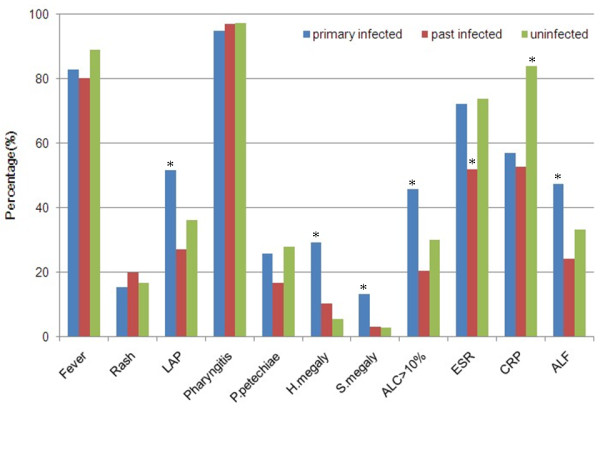
Main clinical features in patients grouped by detection of anti-EBV or anti-CMV antibodies. *Differs from the other two groups, p < 0.05. LAP: lymphadenopathy; P. petechiae: palatal petechiae; H.megaly: hepatomegaly; S.megaly: splenomegaly; ALC: atypical lymphocytes; ESR: erythrocyte sedimentation rate; CRP: C-reactive protein; ALF: abnormal liver function (alanine aminotransferase or aspartate aminotransferase higher than 46 U/L).